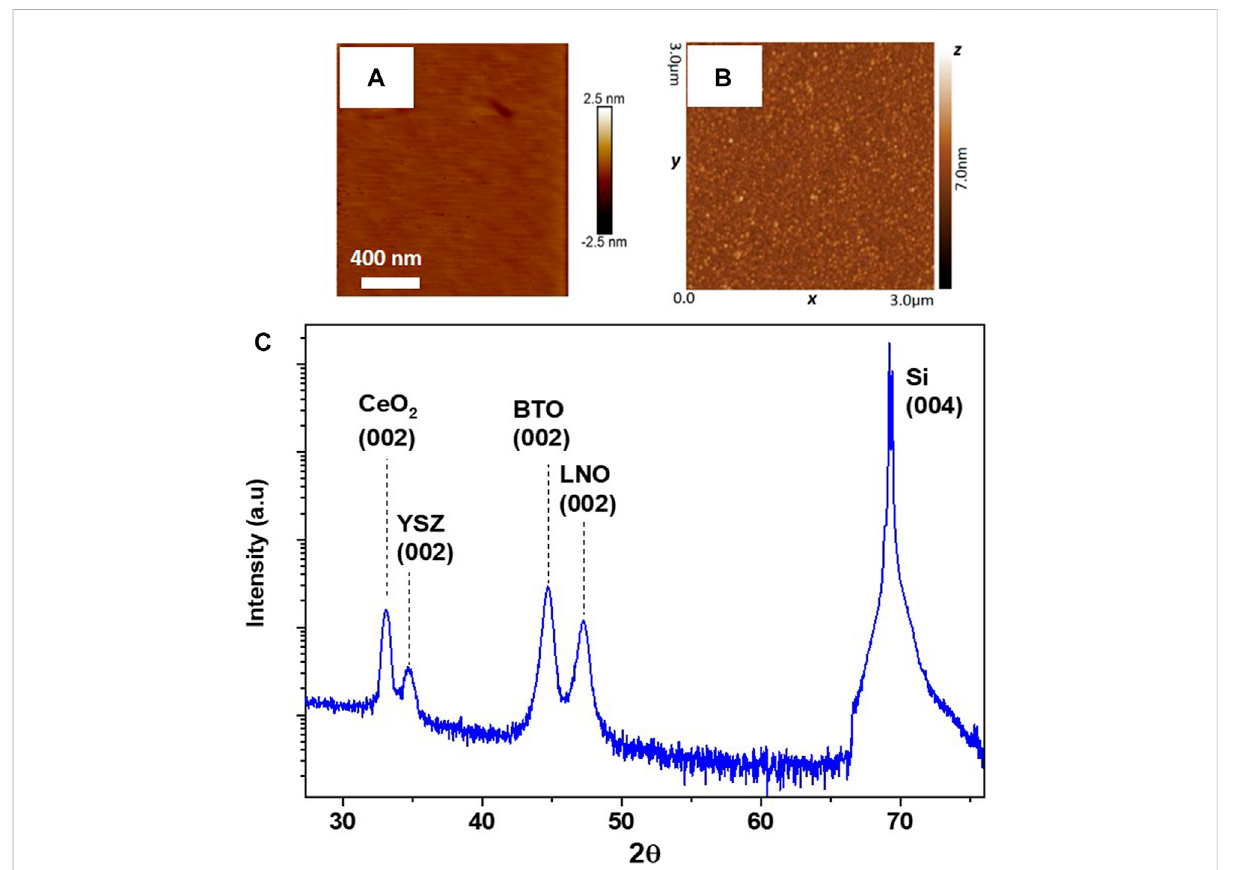
FIGURE 2 (A) Atomic force microscopy topography measured on a Si(001)/YSZ/CeO 2 /LaNiO 3 structure; (B) Atomic force microscopy topography measured on a Si(001)/YSZ/CeO 2 /LaNiO 3 /BaTiO 3 heterostructure; (C) Bragg – Brentano X-ray diffraction pattern corresponding to a Si(001)/YSZ/ CeO 2 /LaNiO 3 /BaTiO 3 heterostructure. LaNiO 3 and BaTiO 3 are labelled as LNO and BTO,